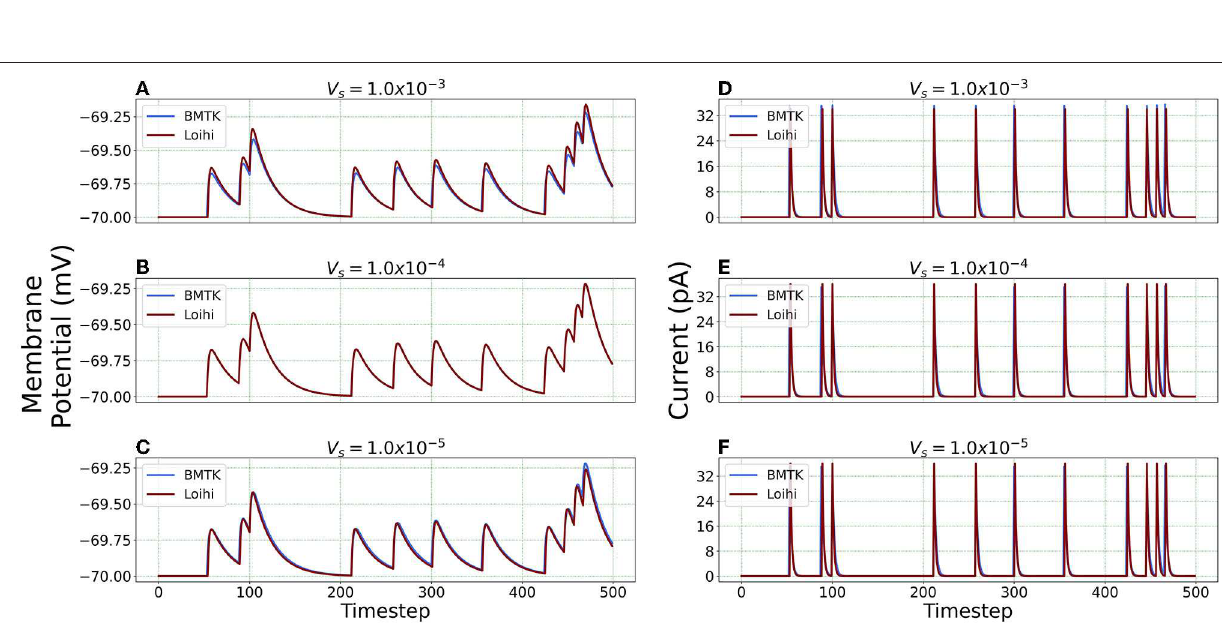
FIGURE 8 | Comparison of membrane potential and current plots with different voltage precisions. Membrane potential plots are on the left with (A) V s = 1.0 × 10 − 3 (B)